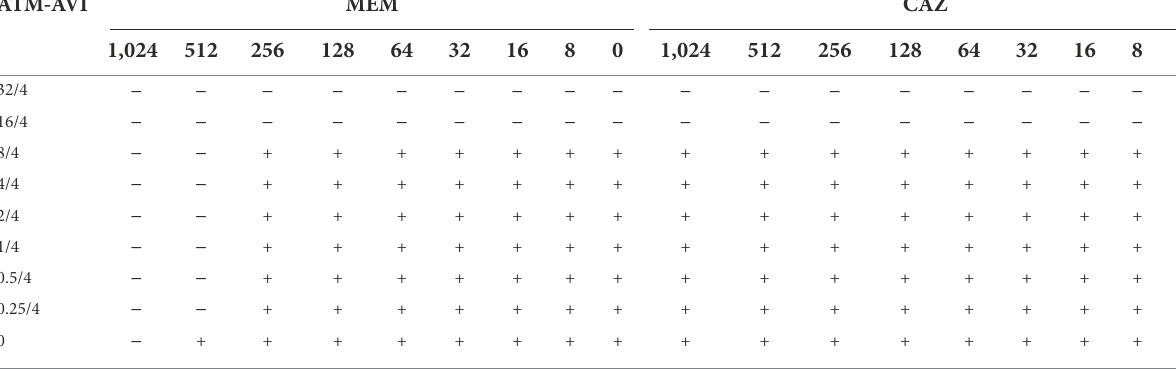
TABLE 2 Checkerboard results (mg/L) of ATM-AVI in combination with MEM or